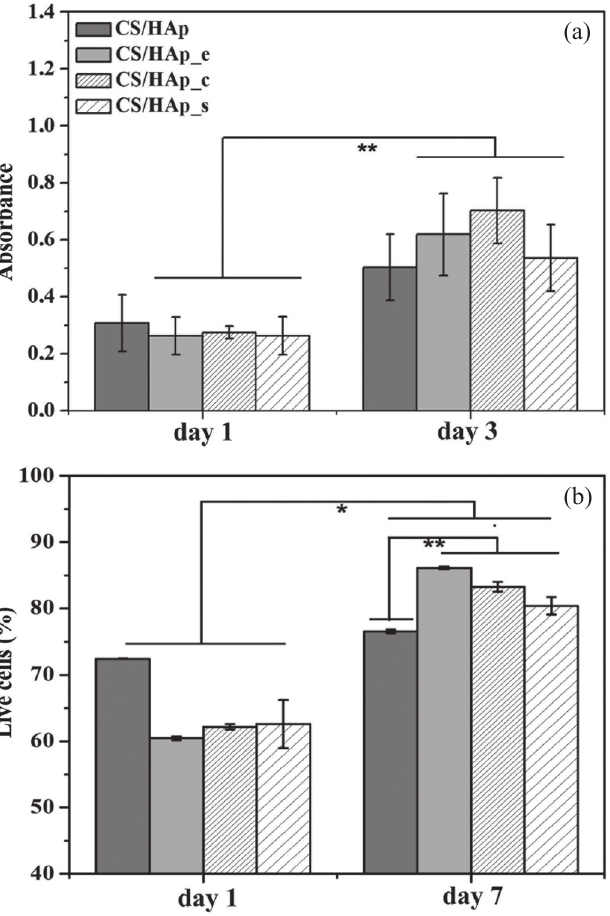
Fig. 7 – Cytotoxicity (a) of CS/HAp scaffolds obtained from different biogenic sources. The viability of human embryonic kidney 293 cells at 1 and 3 days of cell culture expressed by the absorbance at 560 nm. Quantification (%) of live cells (b) on prepared scaffolds (CS/HAp, CS/HAp_e, CS/HAp_c, CS/ HAp_e) determined by Live/dead assay. The significant differ- ence between two groups: * (p < 0.05), ** (p <